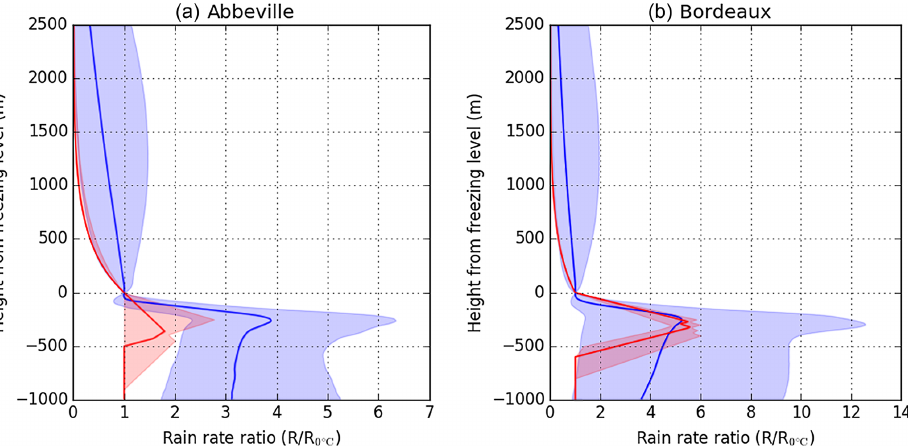
Figure 9. (a) Median VPR predicted by AROME-NWC for 30 April 2018 at 06:00UTC on the Abbeville radar domain (blue) and median VPR of the VPRs used operationally between 05:30 and 06:30UTC for the correction of reflectivities (red). VPRs are expressed as rain rate ratios, rain rate at the freezing level ( R 0 ◦ C ) being the reference. Only profiles with a rain rate greater than 0.1mmh − 1 at the freezing level have been kept. The first and last deciles are delimited by the shaded areas. (b) Same as (a) for 3 March 2018 at 23:00UTC on the Bordeaux radar domain.